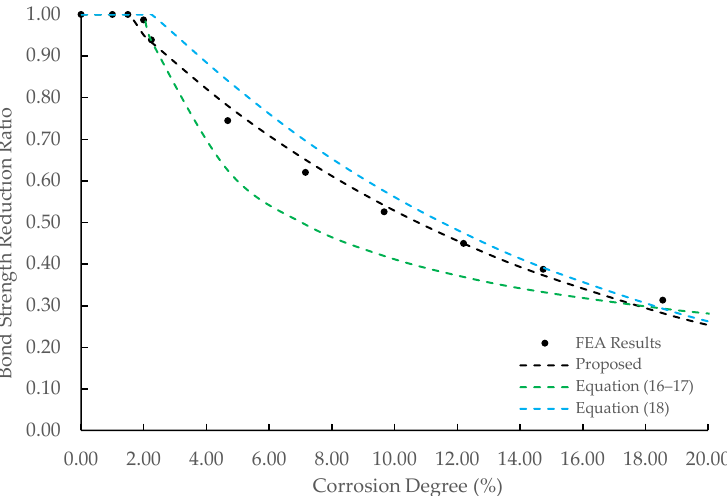
Figure 14. Relationship between corrosion degree and bond strength reduction ratio.